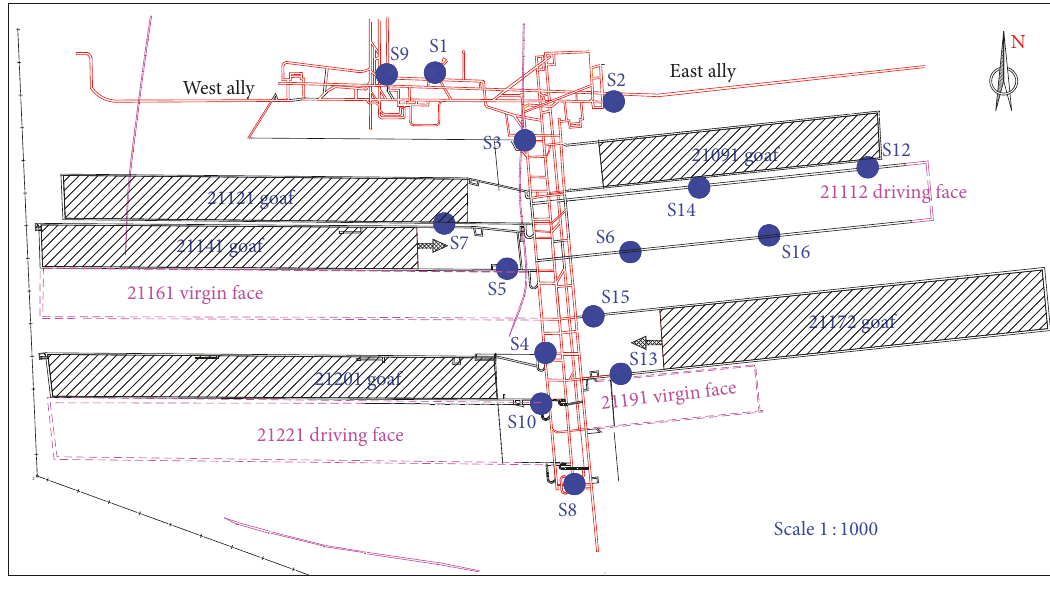
Figure 1: Number 21141 longwall panel and layout of the ARAMIS M/E system sensors